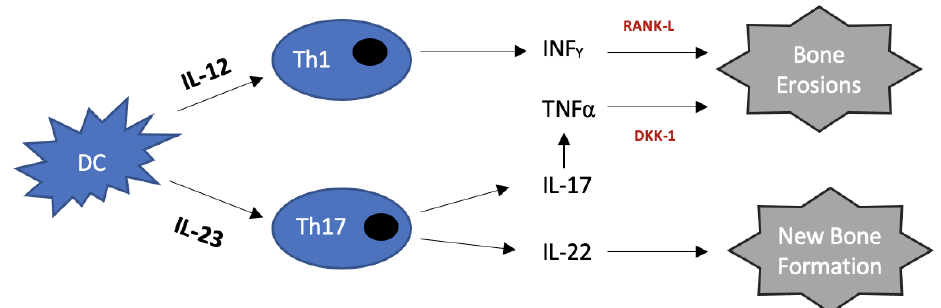
Figure 1. Pathogenesis of psoriatic arthritis. (Adapted with permission from Mantravadi, S. et al., Tumor necrosis factor inhibitors in psoriatic arthritis; published by Expert Review of Clinical Pharma- cology , 2017. Copyright 2017 by Taylor and Francis) Dendritic (DC) and T helper (Th17 and Th1) cells produce several cytokines. TNF α promotes osteoclastogenesis via RANK-L and inhibits osteoblasto- genesis via Dkk-1. This ultimately results in bone erosion formation [49]. IL-22 is involved in new bone formation